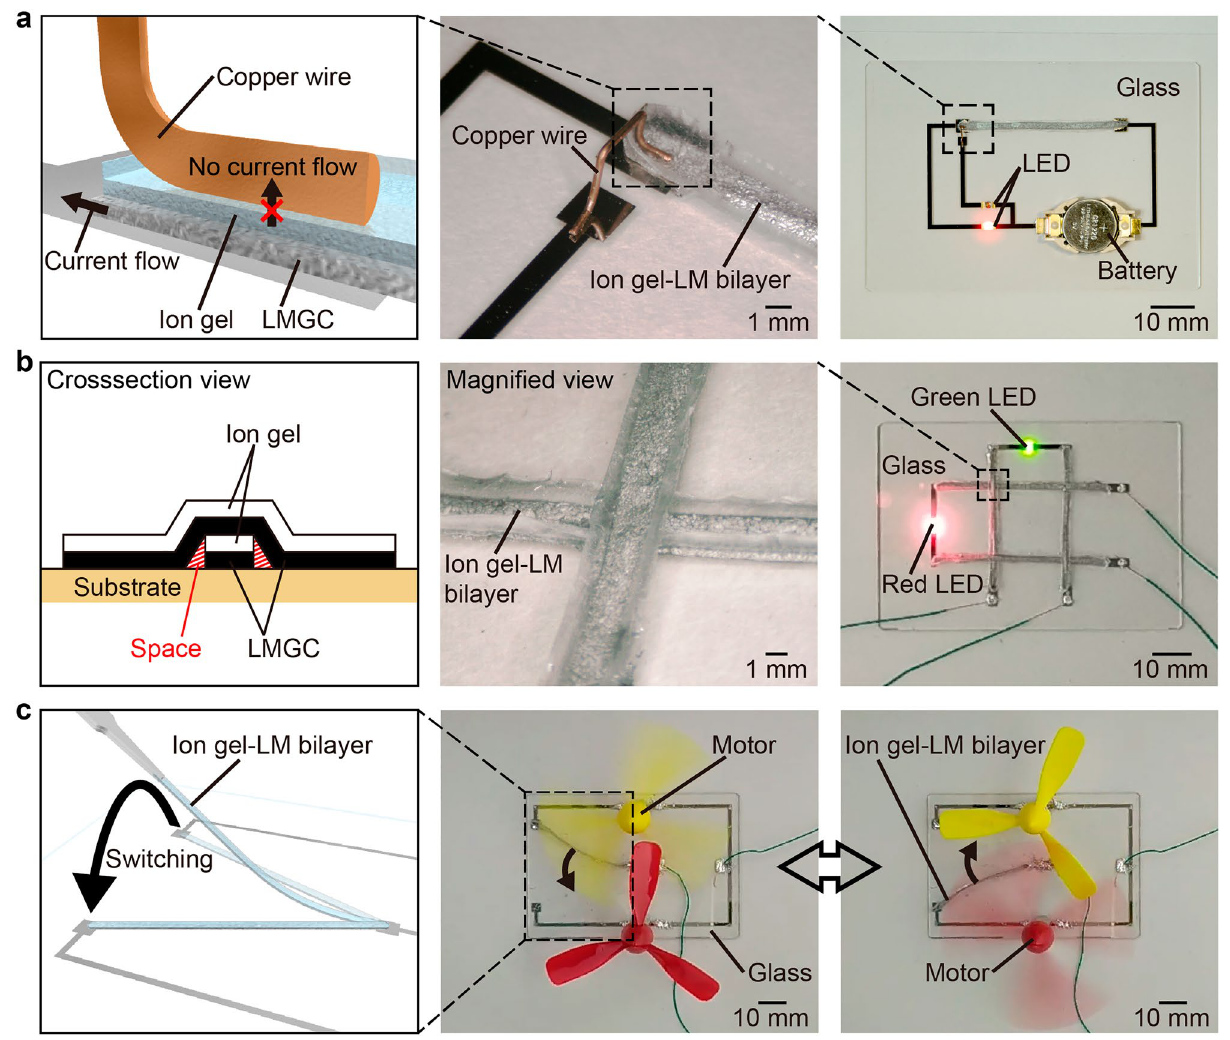
Figure 3. Demonstrations using the ion gel–LM bilayer wiring. ( a ) Verification of the insulative layer performance of the ion gel–LM bilayer wiring. The light-emitting diode (LED) connected to the bottom LMGC conductive layer turned on, but the LED connected to the top ion gel insulating layer did not. ( b ) Construction of a 3D mesh structure using ion gel–LM bilayer wiring. ( c ) Switching circuit using the ion gel–LM bilayer